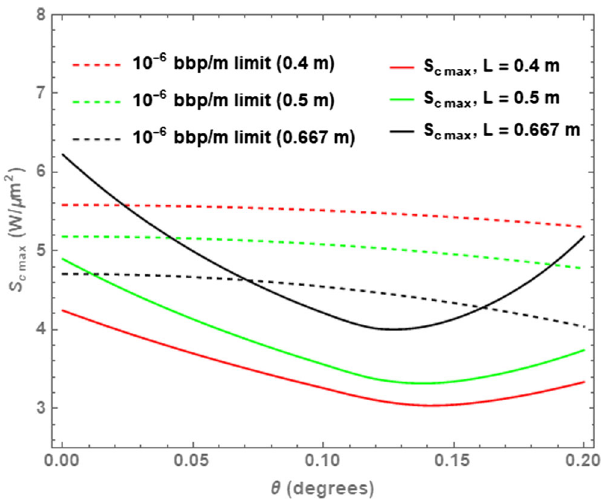
FIG. 16. The power per structure as a function of θ for varying structure